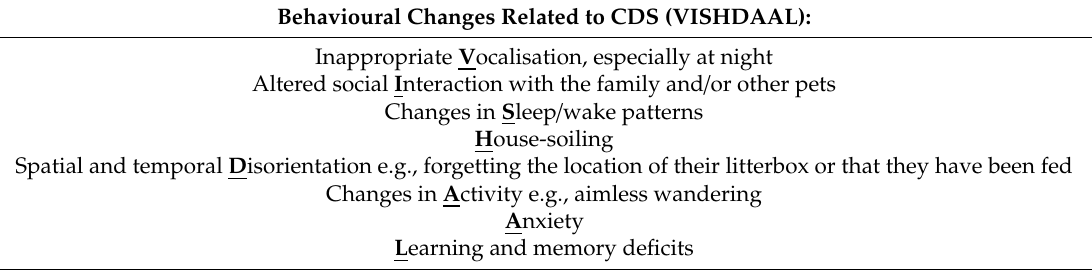
Table 1. Behavioural changes commonly seen in geriatric cats with cognitive dysfunction syndrome (CDS) are summarised by the acronym VISHDAAL [1]. Behavioural Changes Related to CDS